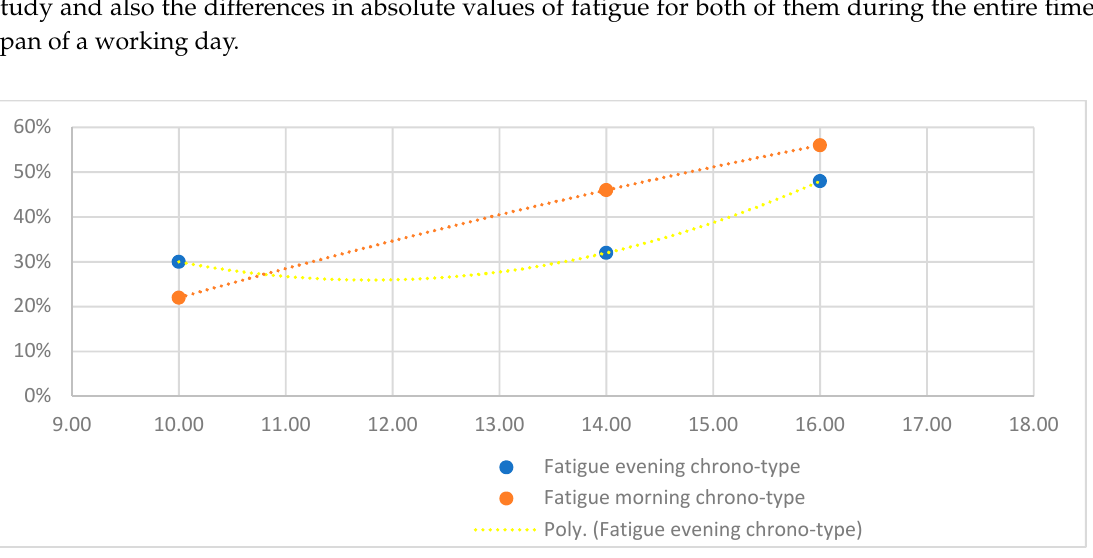
Figure 11. Comparison of the variations of the fatigue during the working day for the evening and morning circadian chrono-type.